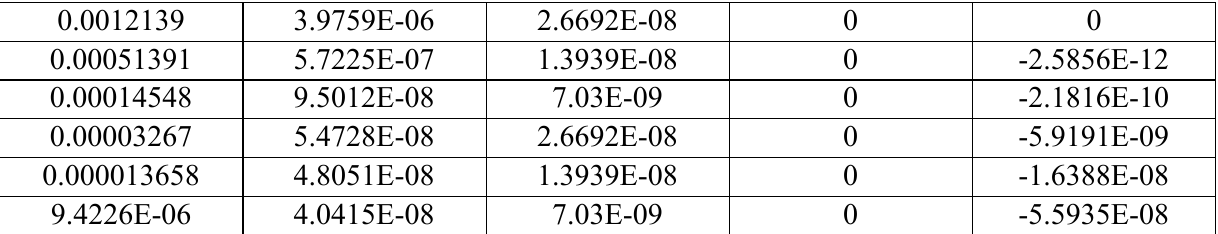
Table I. Typical Mubar Covariance